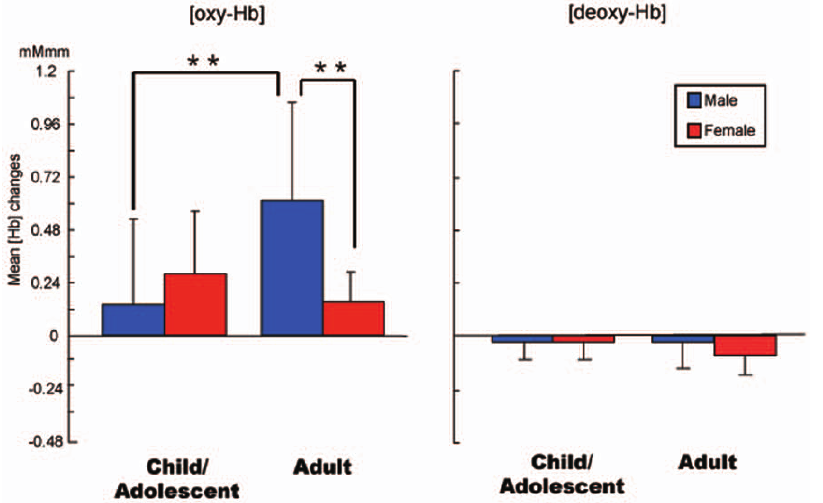
Figure 3. The mean D Hb of the hemispheres in each group. Left: D oxy-Hb, right: D deoxy-Hb, blue: male, red: female. The average D oxy-Hb in the adult group was significantly larger than that in the child/adolescent group for male (F(1,30)=11.55, p , .01). Moreover, for the adult group the average D oxy-Hb in male was significantly larger than that in female (F(1,19)=16.15, p , .01).